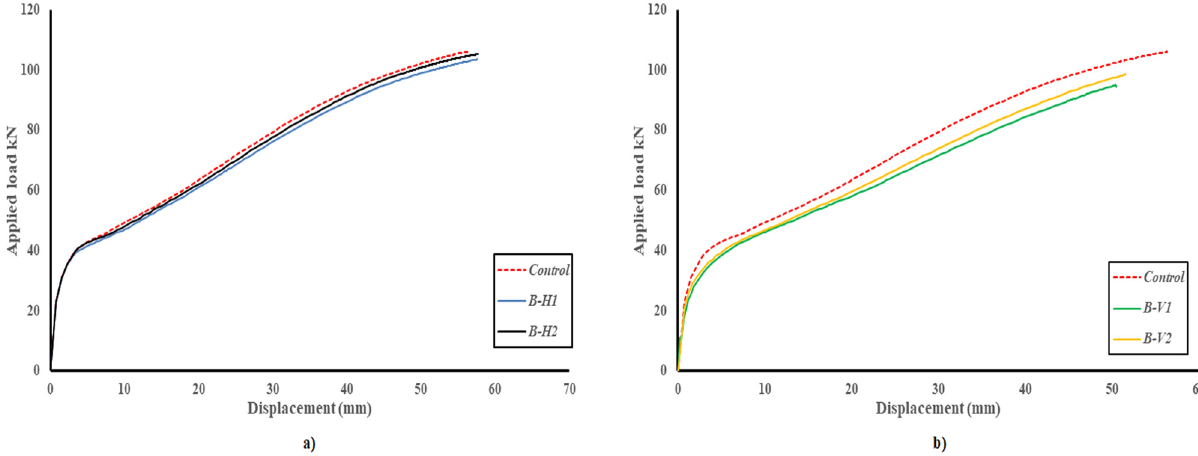
Figure 8: Load – midspan de fl ection response for analyzed beams ( e ff ect of the number of openings ) . ( a ) Beams with horizontal openings and ( b ) beams with vertical openings.